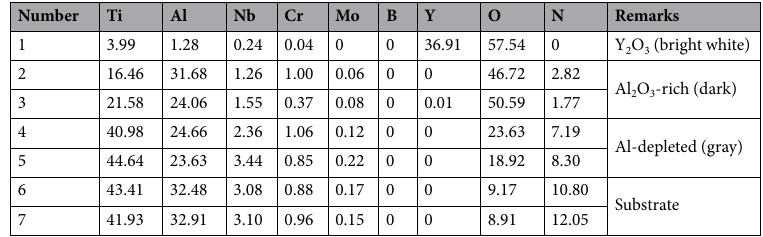
Table 3. Elemental composition (at.%) determined via EPMA at points 1–7 in Fig.